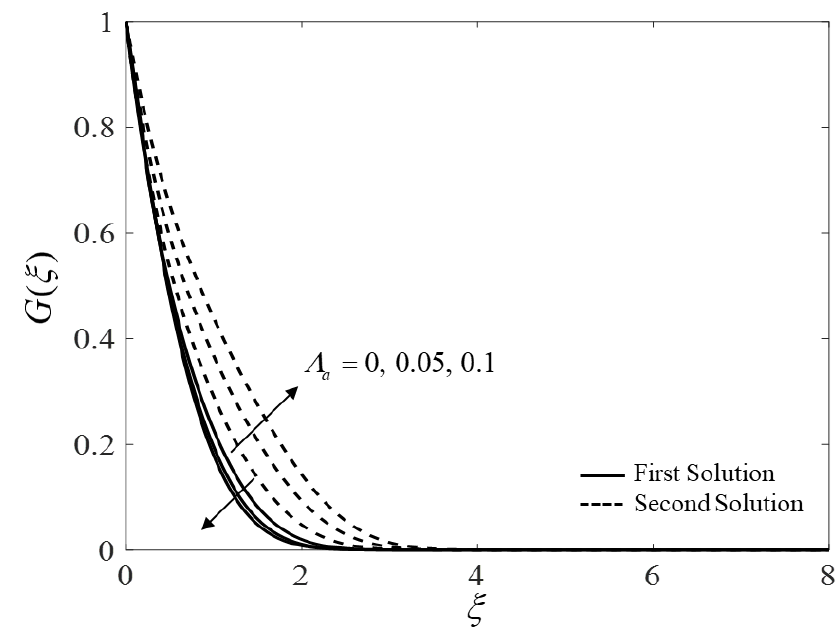
Figure 10. Temperature distribution G ( ξ ) for different values of Λ a .